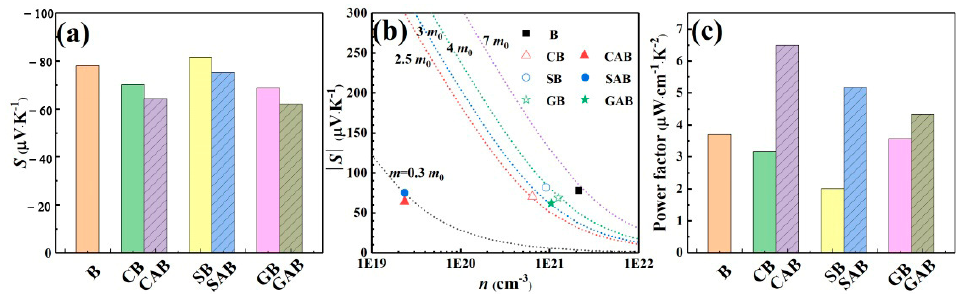
Figure 4. Thermoelectric properties of Bi 2 Te 3 -based films at 300 K. ( a ) Seebeck coefficient ( S ). ( b ) Seebeck coefficient as a function of carrier concentration (Pisarenko plot). Dashed lines represent theoretical fits for m * = 0.3 m 0 , 2.5 m 0 , 3 m 0 , 4 m 0 and 7 m 0 based on Equations (1)–(3). m 0 is mass of free electron. ( c ) Power factor ( S 2 σ ).